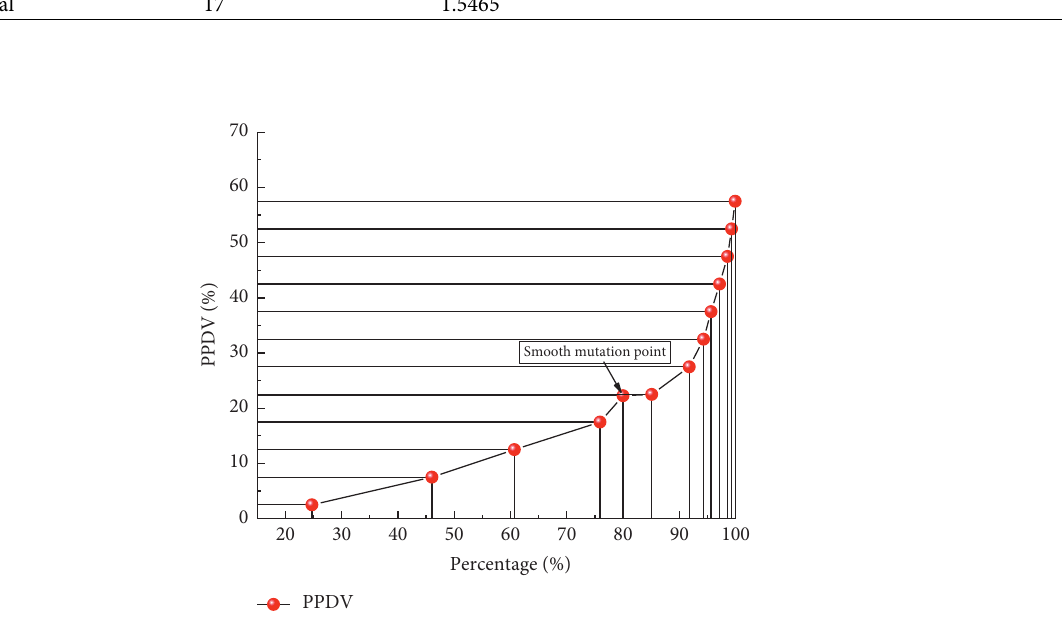
Figure 7: Percentage distribution of PPDV in nontunnel section.